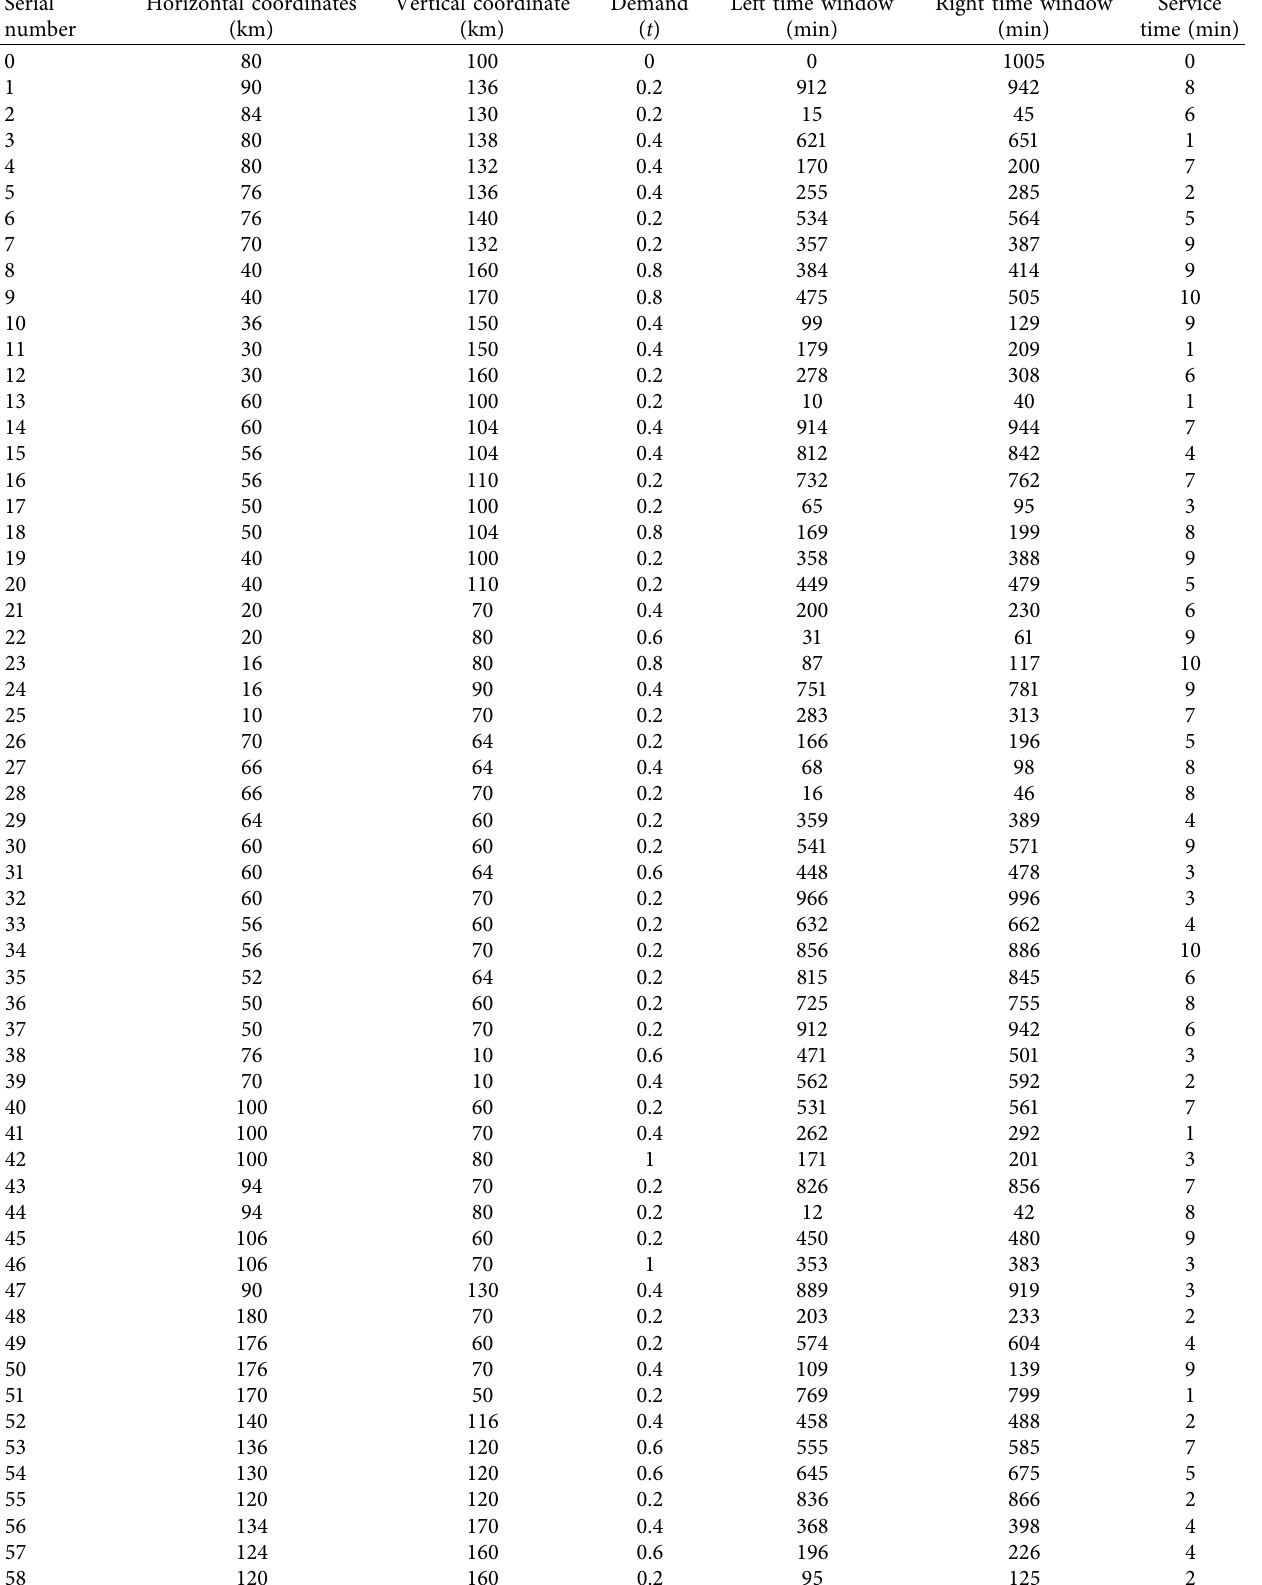
Table 2: Customer information